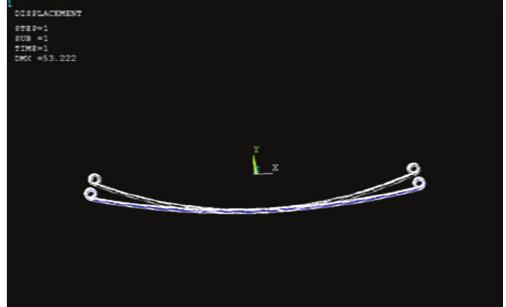
Figure 2: Geometry of leaf spring in ANSYS before and after